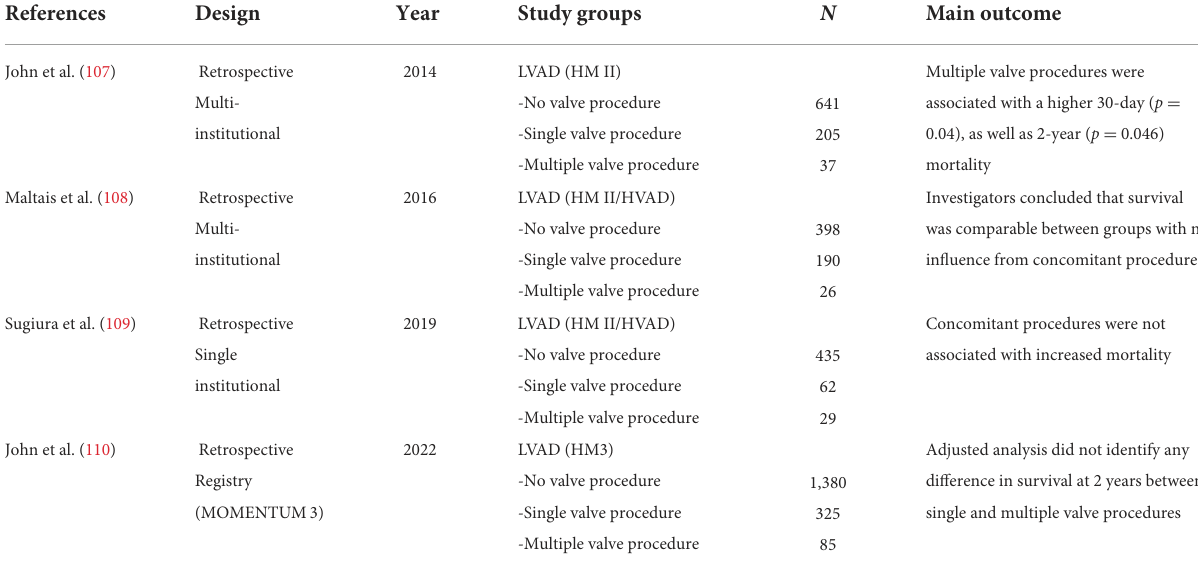
TABLE 4 Key studies in chronological order of publication reporting on the outcomes of concurrent multiple valve procedures during LVAD